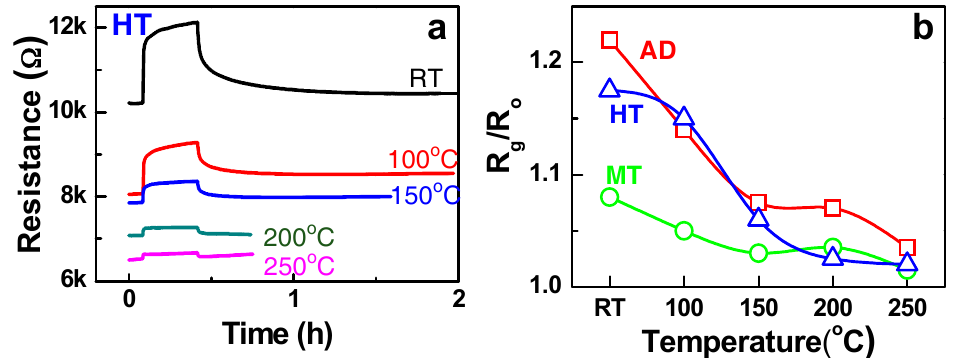
Figure 4. ( a ) The response-recovery curves of the HT structure measured for 500 ppm NH 3 with varying temperatures. ( b ) The temperature dependence of the response levels of the AD, MT, and HT (500 ppm NH 3 ) structures.